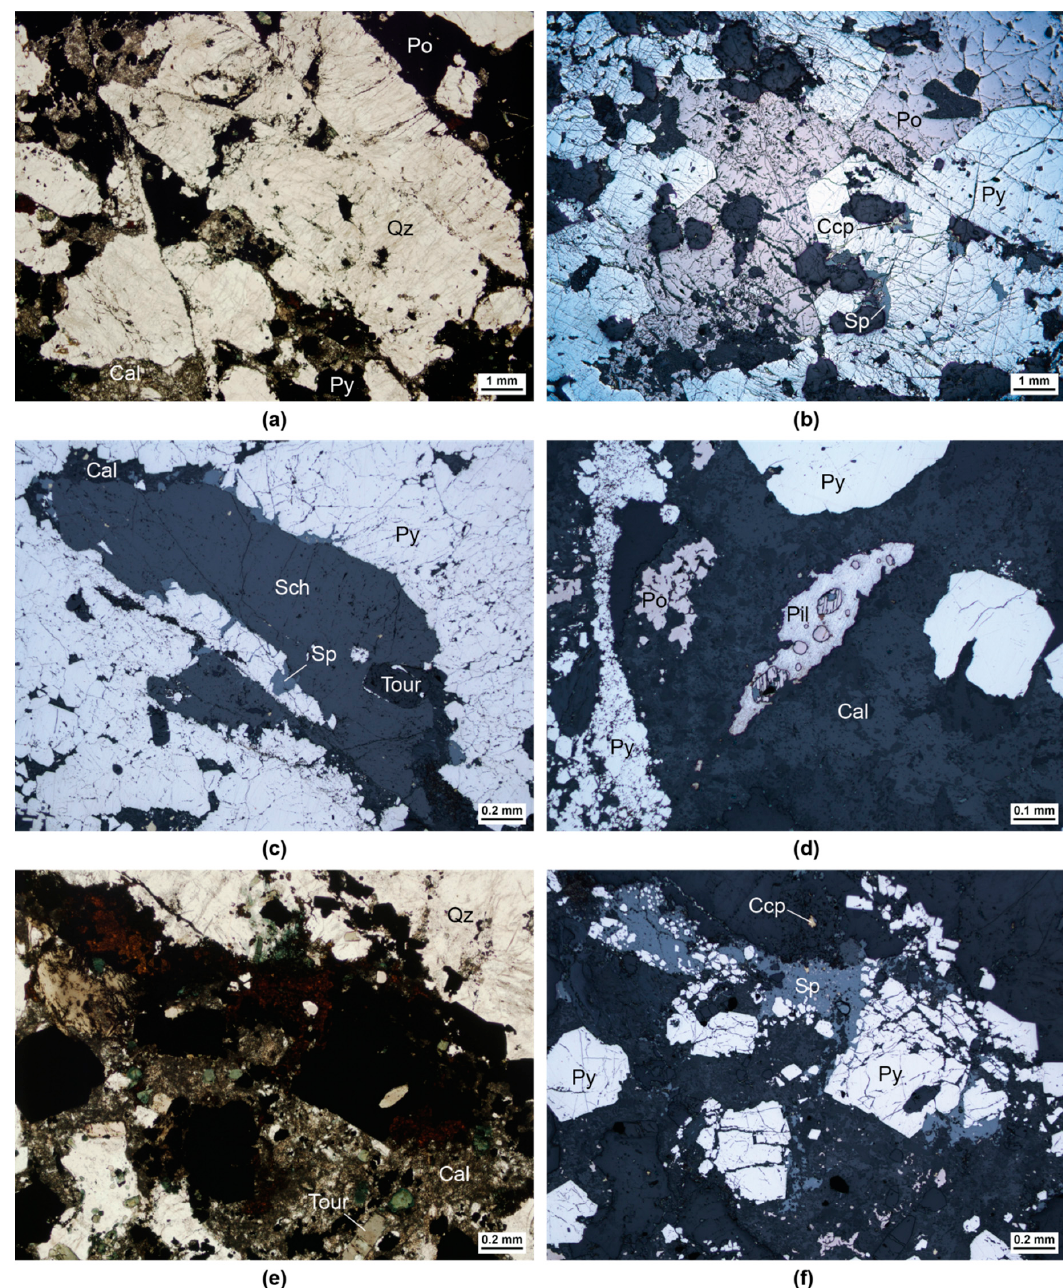
Figure 2. Petrographic images of the thin section analyzed by QEMSCAN ® in this study. (a) and (e) are plane polarized light images, (b), (c), (d), and (f) are reflected light images; (a) grains of quartz surrounded by patches of calcite, and pyrrhotite and pyrite; (b) massive pyrrhotite and subhedral pyrite. Sphalerite and chalcopyrite occur along the edges and in cracks of pyrite; (c) scheelite grain within pyrite; (d) grain of pilsenite with patches of pyrrhotite surrounded by calcite; (e) and (f) assemblage of sphalerite, pyrite, calcite and tourmaline surrounded by quartz. Abbreviations: